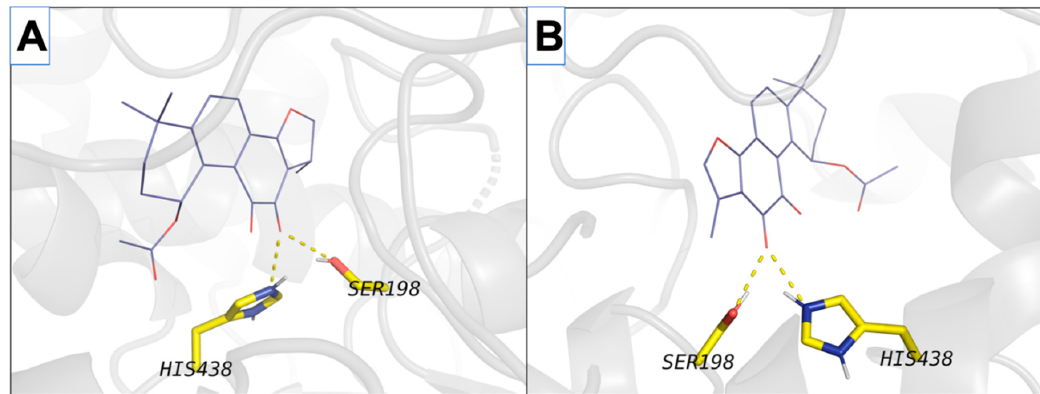
Figure 5. Interactions of isolated compounds from Perovskia atriplicifolia extracts (purple skeleton) that only interact with BChE, in transparent grey cartoon fashion. Shown compounds are ( 1R,15R )-1-acetoxycryptotanshinone ( A ), and ( 1R )-1-acetoxytanshinone IIA ( B ). Residues are colored according to their binding areas as yellow (catalytic triad) and green (peripheral anionic site). Hydrogen bonds established between compounds and depicted residues are shown with deep yellow dashed lines.